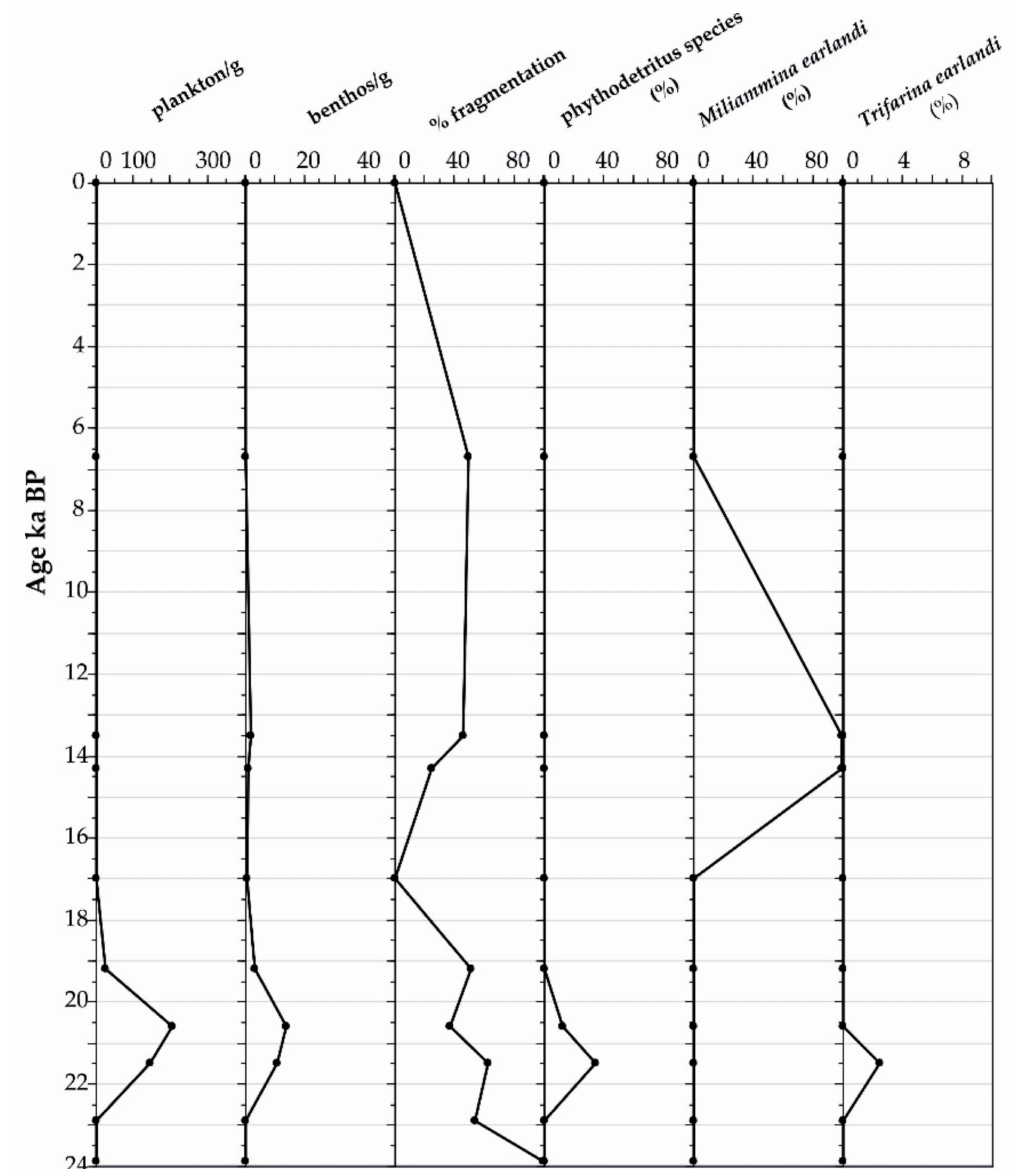
Figure 12. From left to right: down-core distribution in BC04 of planktic N. pachyderma and benthonic foraminifera (as the number of specimens per gram of dry sediment), fragmentation (%), and relative abundance (%) of benthic foraminifera. The phytodetritus species includes the % of A. weddellensis and E. exigua